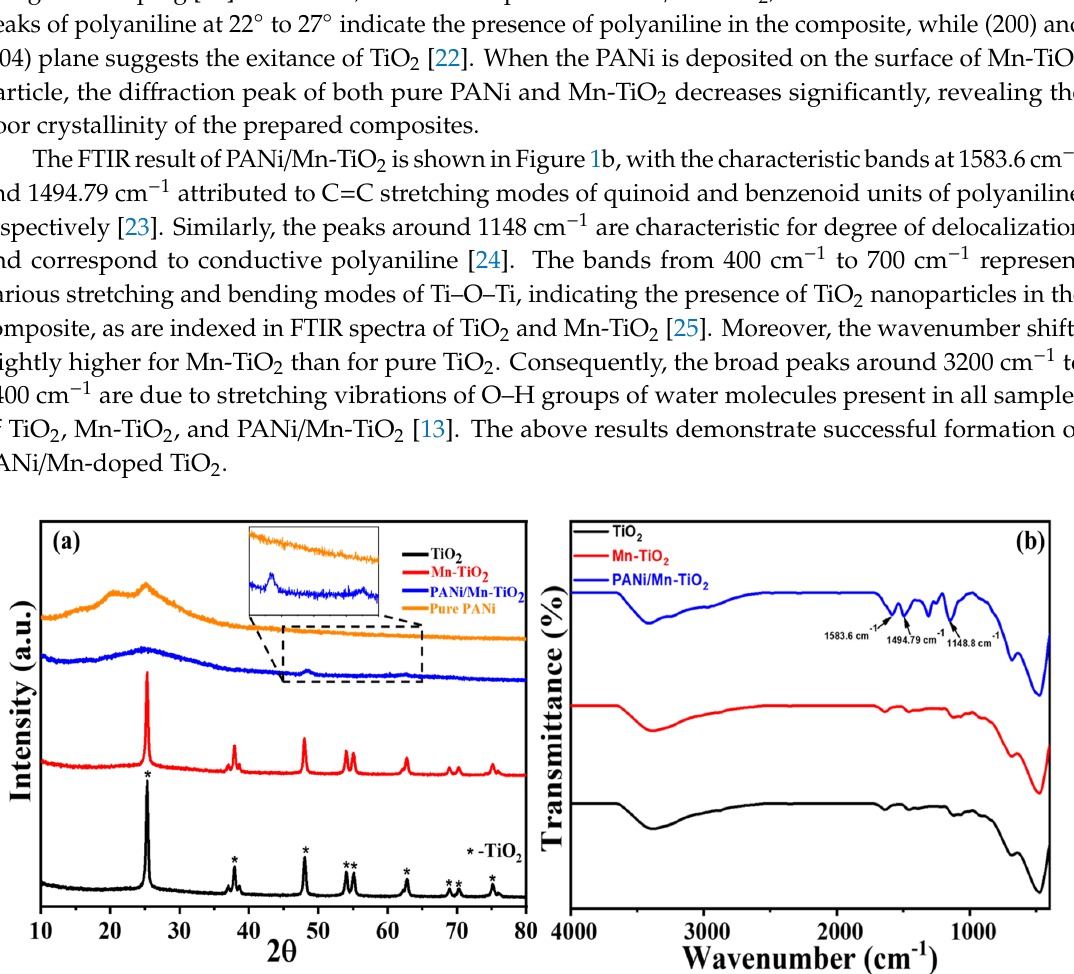
Figure 1. ( a ) XRD plots of TiO 2 , Mn-TiO 2 and PANi / Mn-TiO 2 nanoparticles (inset shows the magnified di ff raction patterns within 2 θ = 45 ◦ to 65 ◦ ), and ( b ) FTIR spectra of TiO 2 , Mn-TiO 2 and PANi / Mn-TiO 2 nanoparticles.